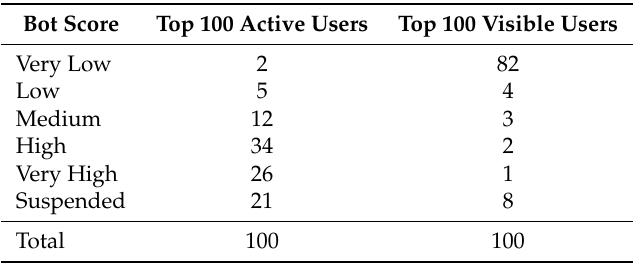
Table 3. Bot Score Summary.